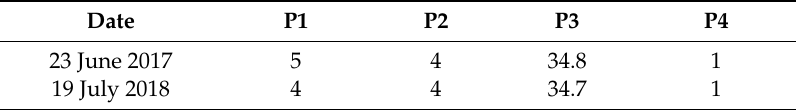
Table 2. A set of similar load